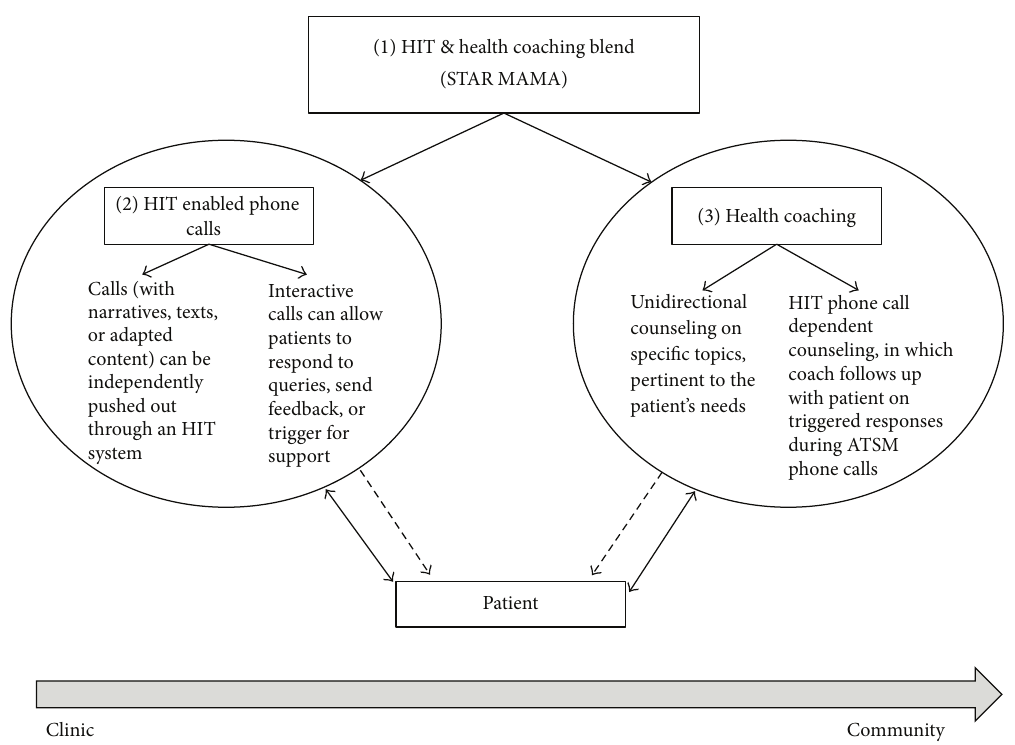
Figure 4: Multimodal adaptation of the STAR MAMA HIT/health coaching hybrid model to meet community needs. This model breaks down the different modes of implementation of the STAR MAMA model to illustrate the flexibility of supporting self-managed care within the clinic to community spectrum. Both components of the model, HIT and health coaching, have the capacity to interact uni- or bidirectionally with the patient in the clinic or community setting. (1) STAR MAMA: the STAR MAMA intervention is a blend of weekly HIT phone calls to eligible patients and health coaching calls for support and follow-up. (2) ATSM: this is one component of the STAR MAMA model, in which patients receive weekly phone calls for 20 weeks on various topics regarding postpartum health. The calls can be implemented in the community setting unidirectionally, in which the patient listens to educational narratives, or the phone calls can be programmed to offer an interactive component. (3) Health coaching: trained health coaches can provide topic-based counseling to patients regarding specific topics tailored to the patient’s needs. Or the health coach can receive triggers from an HIT system (if both are used in conjunction) to follow-up with patient on high risk